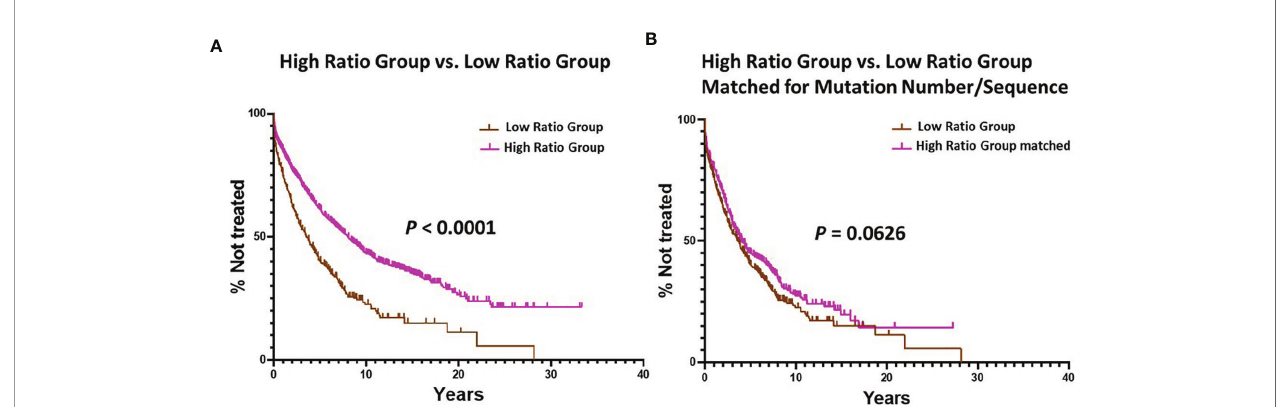
FIGURE 4 | Comparison of estimated TTFT between the Low Ratio Group and the High Ratio Group. (A) Comparison of TTFT between the Low and High Ratio Groups using all patients in the respective groups (P < 0.0001). Number in Low Group = 405, median = 3.56 years; number in High Group = 1934, median = 8.03 years. (B) Comparison of TTFT after matching the Low and High Ratio Groups for equal numbers of patients (n = 405) with equal numbers of mutations per sequence (range: 1 – 36). Low Group median = 3.56 years, and High Group median = 4.08 years; P =